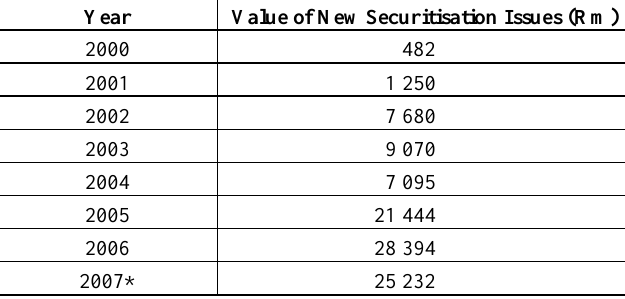
Table 1: Value of new securitisation issues (Rm)